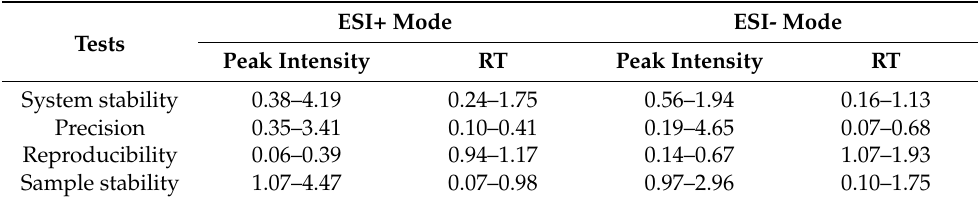
Table 1. The RSDs (%) of peak intensity and RT in validation tests.